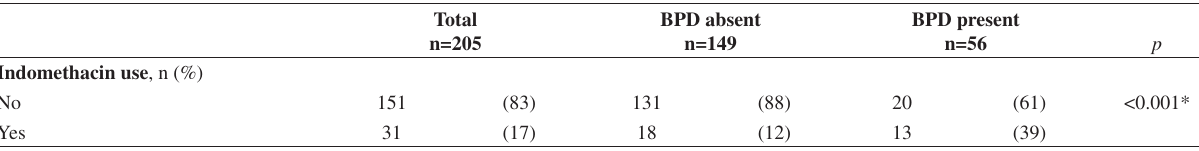
Table 11 - Indomethacin use during the first week of life for patent ductus arteriosus treatment in BPD and non-BPD